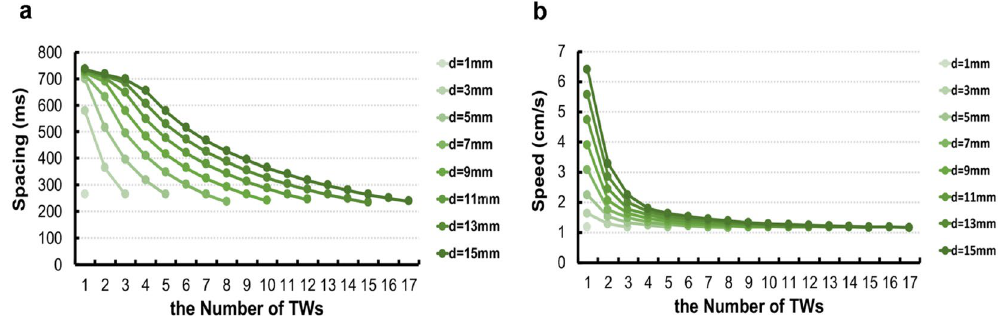
Figure 3. Spacings and speeds of traveling waves computed based on the restitution functions. ( a ) The spacings of traveling waves of different numbers in varied diameters calculated from Eq. 5 and restitution functions. ( b ) The speeds of traveling waves in different diameters and numbers computed from restitution